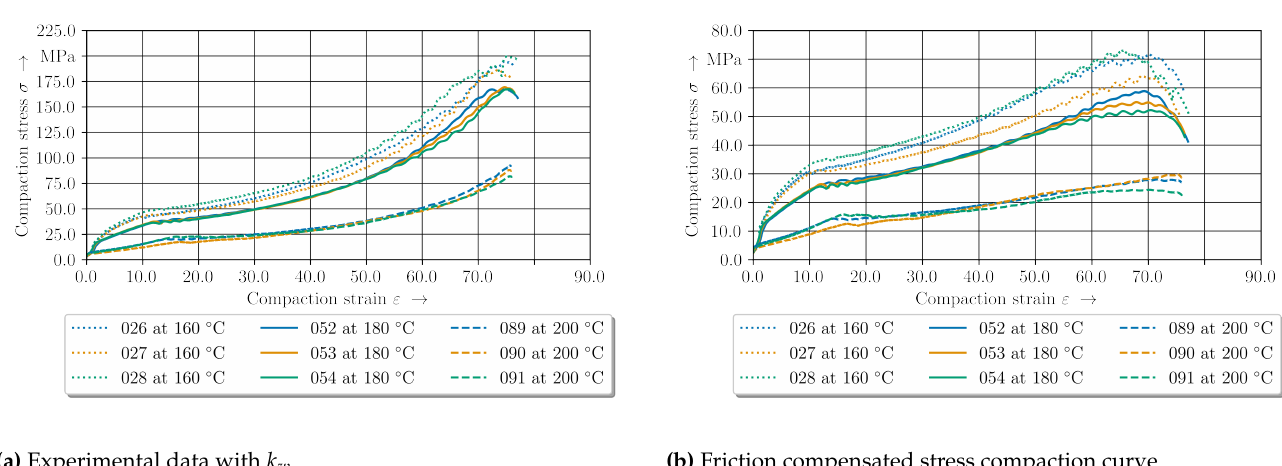
Figure 10. Experimental stress compaction curves of the 2mm–configuration for the three different temperature levels ( a ) without friction compensation ( b ) with friction compensation according to